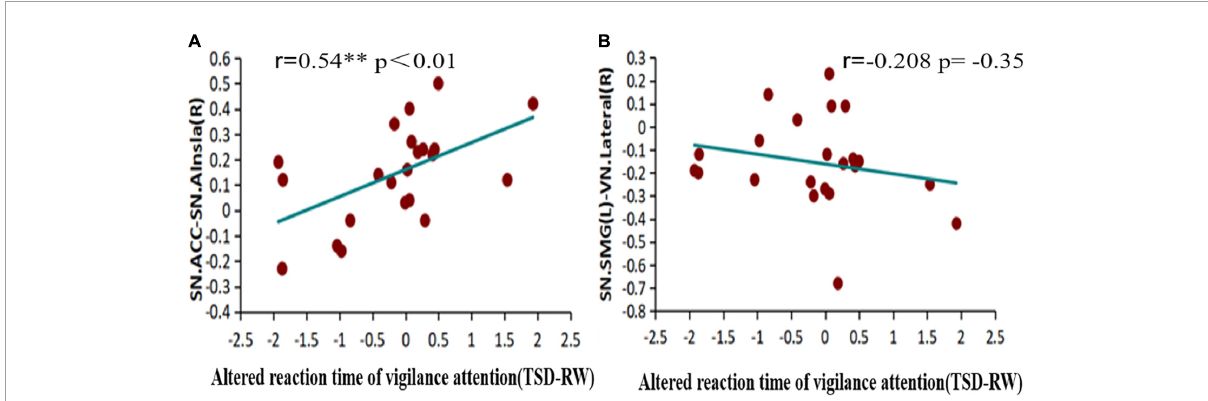
FIGURE7 Alerted functional connectivity correlate to altered reaction time of vigilance attention: altered reaction time of vigilance attention is (A) positively correlated with the alerted functional connectivity of ACC-Alsula (R) [within salience network (SN)], and (B) negatively correlated with the alerted functional connectivity of SMG(L)-Lateral(R) (SN-VN) TSD, total sleep deprivation; RW, rested wakefulness; ACC, anterior cingulate cortex; SMG(L), left supramarginal gyrus; VN, visual network. * p < 0.05, ** p < 0.01, *** p <